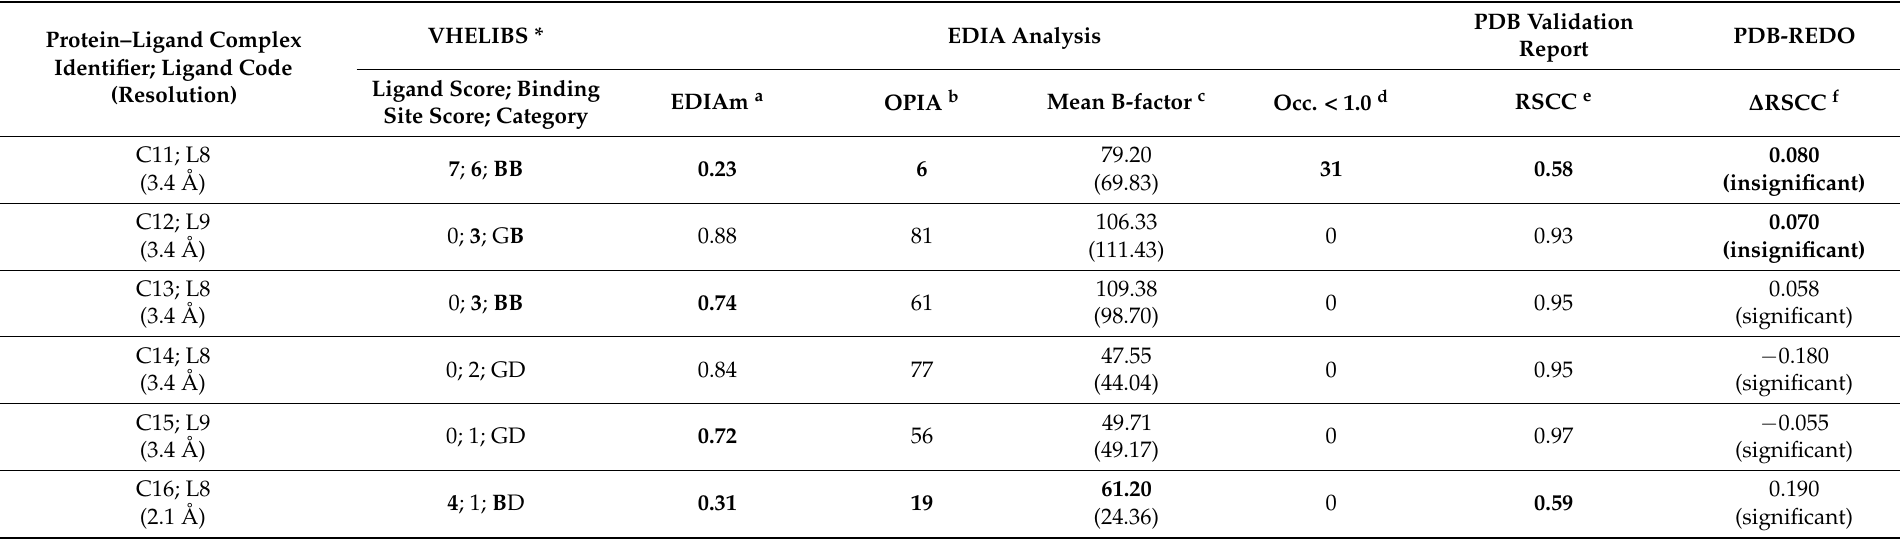
Table 3. Quality assessment of ligands bound to the structures C11–C16 (case